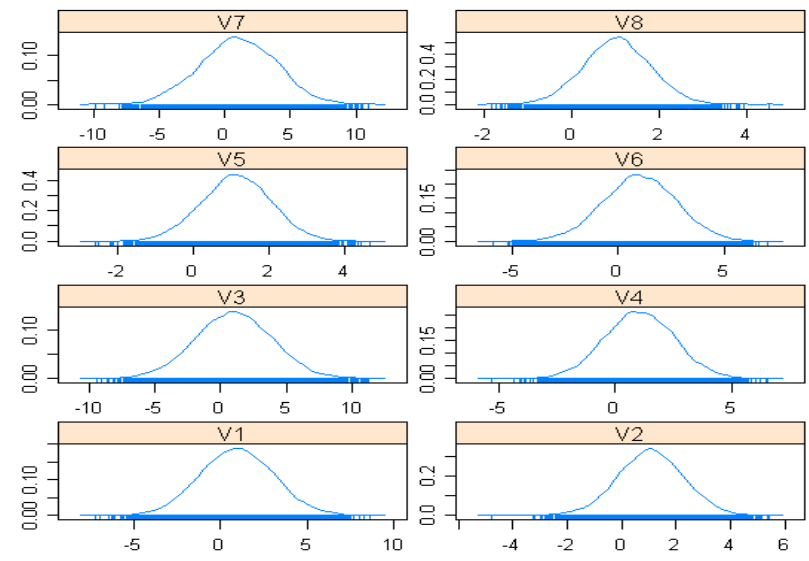
Figure 1. Density plots of β 0 , . . . , β 7 for the HBLD